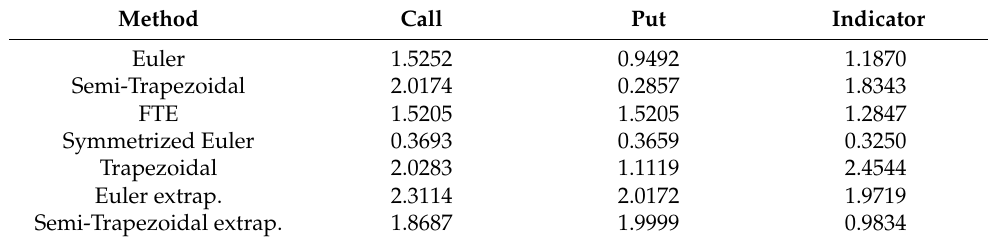
Table 1. Measured convergence rates Model 1.